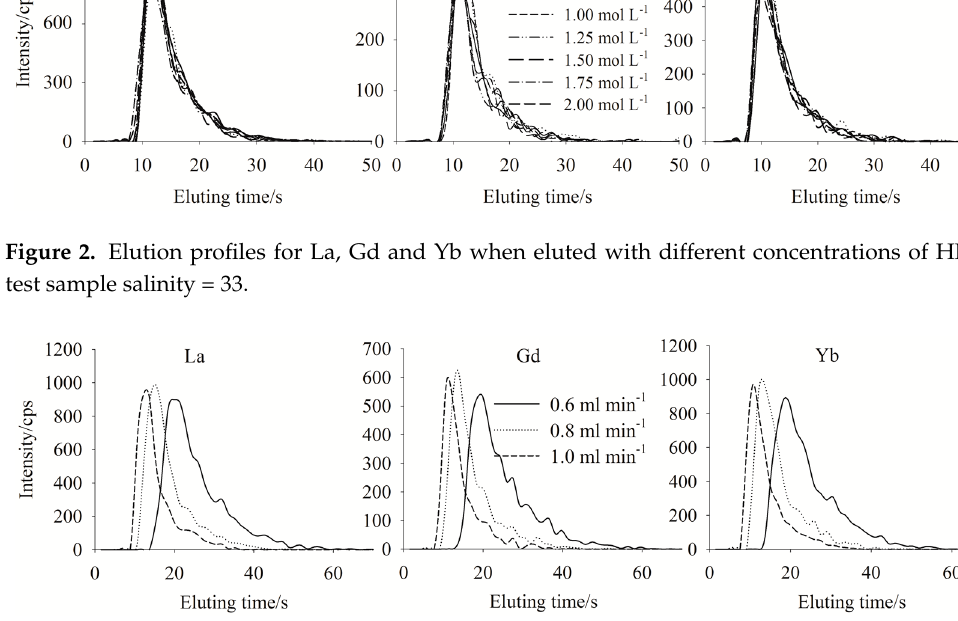
Figure 4. Standard additions calibration curves for Y based on samples having different matrices.